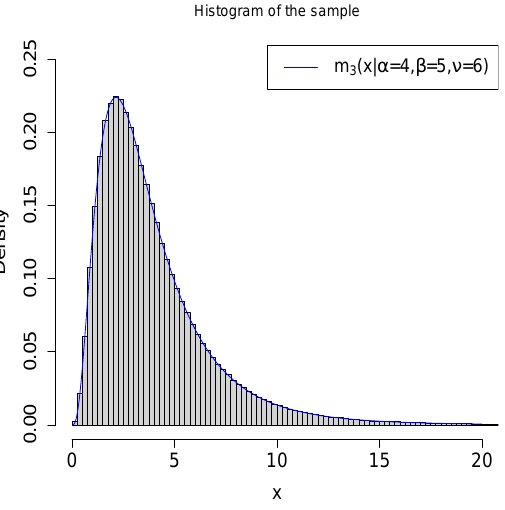
Figure 9. The histogram of the sample x with the marginal density m 3 ( x | α = 4, β = 5, ν = 6 ) .